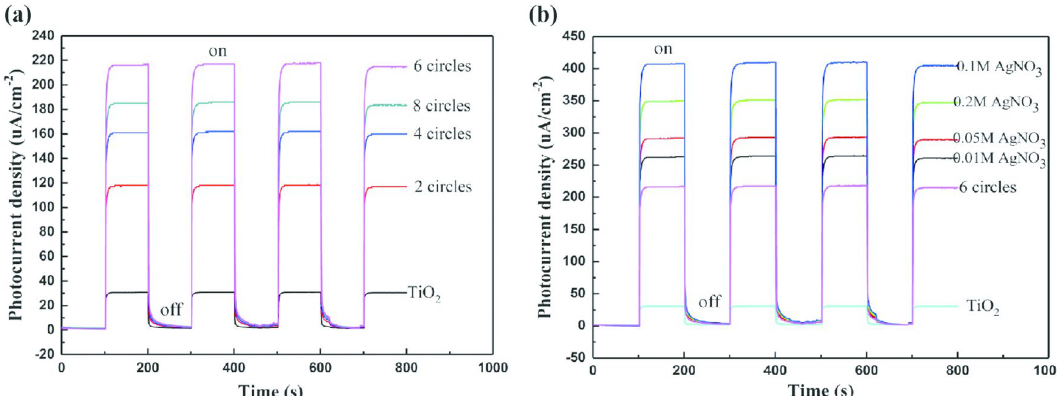
Figure 5. Photocurrent density variations of the 304 SS electrode coupled with the NiS/TiO 2 nanocomposite ( a ) and Ag/NiS/TiO 2 nanocomposite ( b ) with and without illumination (λ > 400